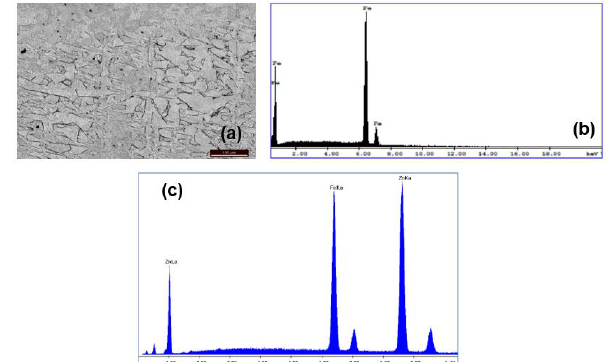
Figure 11: (a) Cross-sectional optical micrograph of the diode stud portion in etched condition, etchant: acidified potassium dichromate, (b) magnified view of the encircled region in Figure 11, (c) diode shell microstructure in etched condition showing MnS stringers, etchant: 2% nital, (d) etched shell microstructure in higher magnification showing whitish coating.